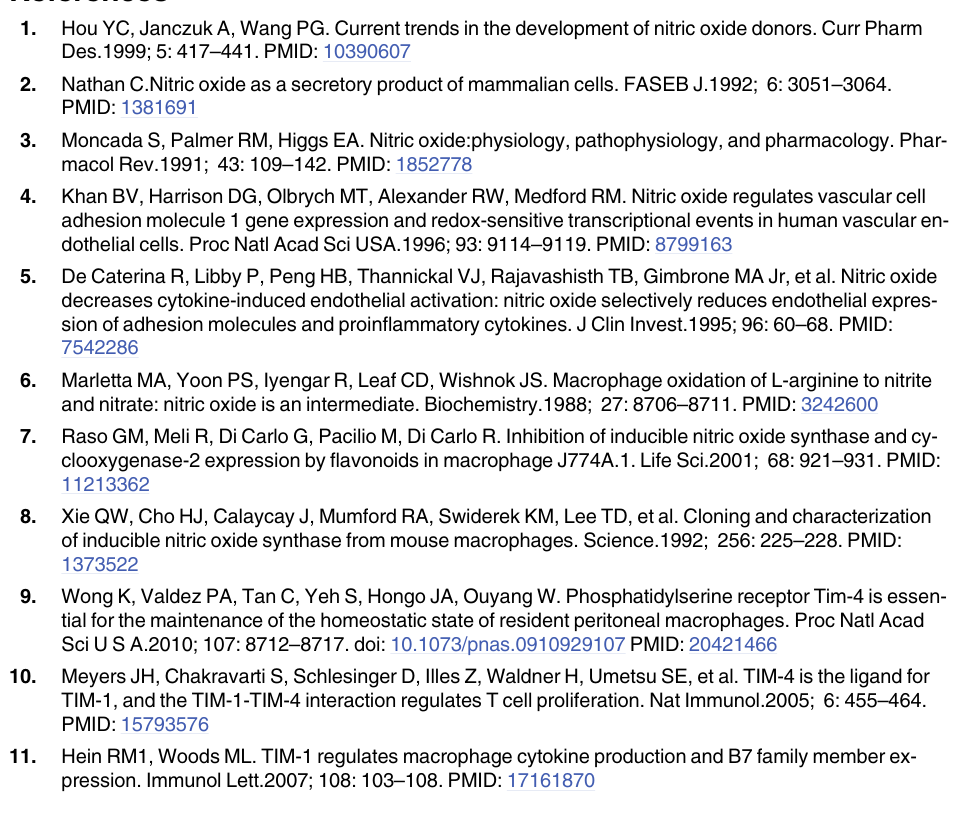
S1 Fig. The phenotype of peritoneal macrophages and RAW264.7 cells.